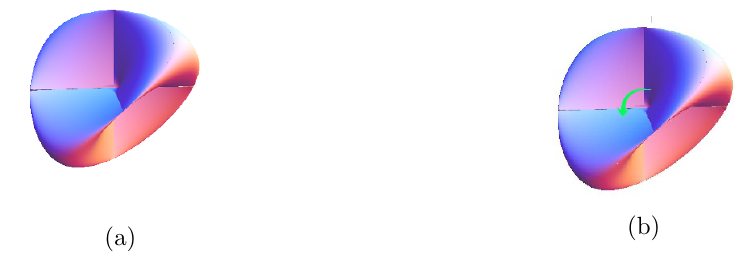
Figure 1. (a) 3-dimensional section of squashed C P 2 . (b) 3-dimensional section of squashed C P 2 , with zero mode connecting 2